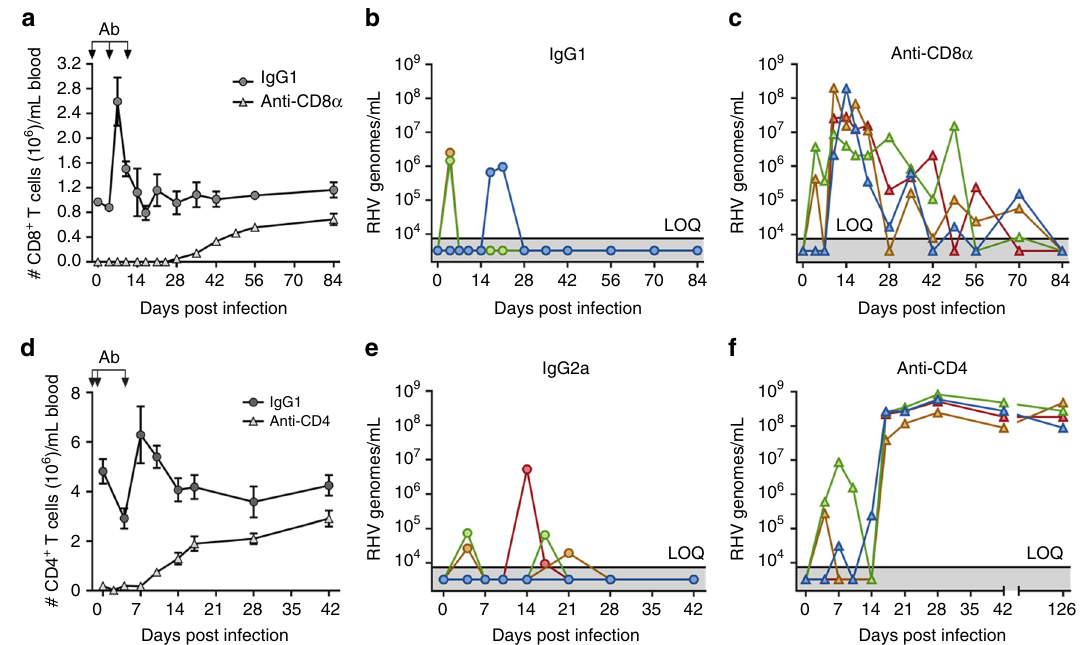
Fig. 5 Vaccine-driven virus resolution is CD4 + and CD8 + cell-dependent. Lewis rats were injected intramuscularly with 5 × 10 8 ifu Ad-NSmut. After 3 weeks, rats were challenged intravenously with 10 6 genomes RHV. a – c At days − 2, 5, and 12 post infection, rats were transiently depleted of CD8 α + cells by antibody or isotype control. a Number of CD8 + T cells/mL blood of IgG1 and anti-CD8 α antibody-treated rats as determined by fl ow cytometric analysis. Arrows indicate timing of antibody administration. Data from n = 4 rats per group are shown (mean ± SEM). b , c Viremia in IgG1 and anti-CD8 α antibody treated rats. Solid line with below shading indicates limit of quanti fi cation (LOQ) of RT-PCR. d – f At days − 3, − 1, and 4 post infection, rats were transiently depleted of CD4 + cells by antibody or isotype control. d Number of CD4 + T cells/mL blood of IgG2a and anti-CD4 antibody-treated rats as determined by fl ow cytometric analysis. Arrows indicate timing of antibody administration. Data from n = 4 rats per group are shown (mean ± SEM). e , f Viremia in IgG2a and anti-CD4 antibody treated rats. Solid line with below shading indicates LOQ of